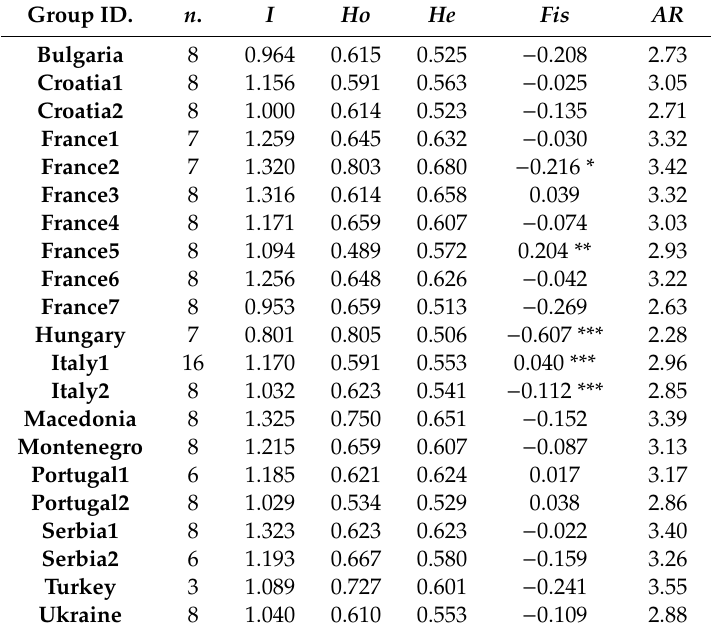
Table 4. Summary of genetic variation statistics at 11 nSSR loci on FAN samples belonging to set #2. Individuals were grouped based on sampling location (see Table